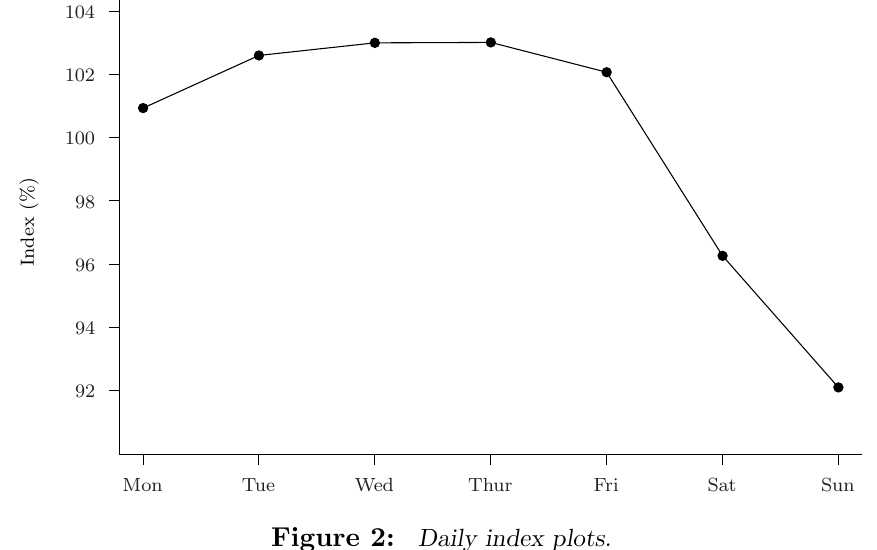
Figure 2: Daily index